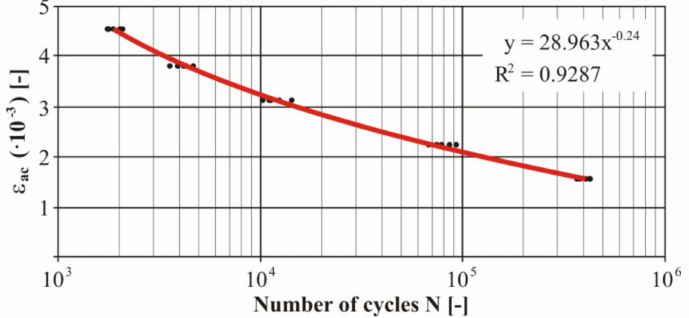
Figure 24. The final Manson − Co ffi n fatigue curve of the welded material EN AW 6063 under the bending load.